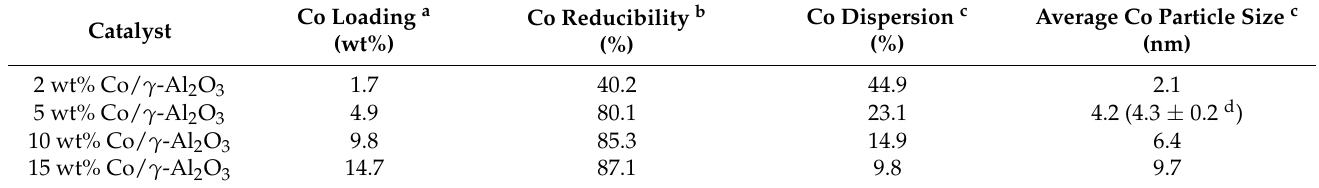
Table 1. Mass loading, reducibility, dispersion, and particle size of Co for the Co/ γ -Al 2 O 3 catalysts used in this study. Co Loading a Co Dispersion c Co Reducibility b Catalyst (wt%) (%)